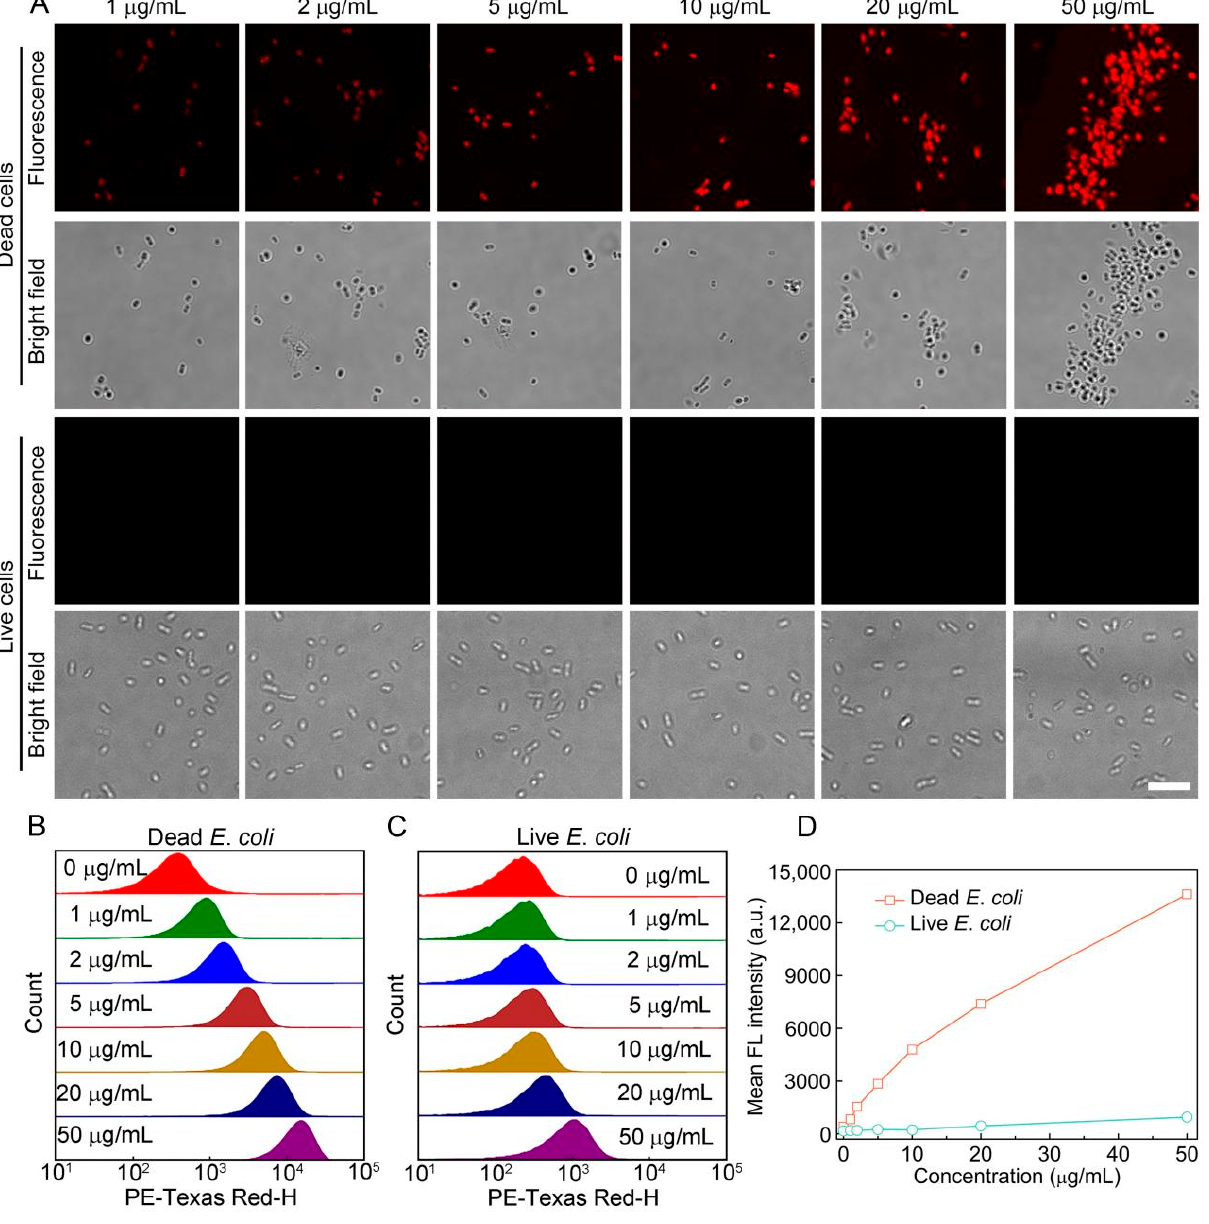
Figure 1. ( A ) Confocal images of dead and live E . coli cells incubated with various concentrations of S ‐ OSiNDs for 30 s. Scale bar = 10 μ m. Flow cytometric results of the dead ( B ) and live ( C ) E . coli cells incubated with different concentrations of S ‐ OSiNDs for 30 s and ( D ) corresponding quantitative mean fluorescence intensities derived from the flow cytometric results.